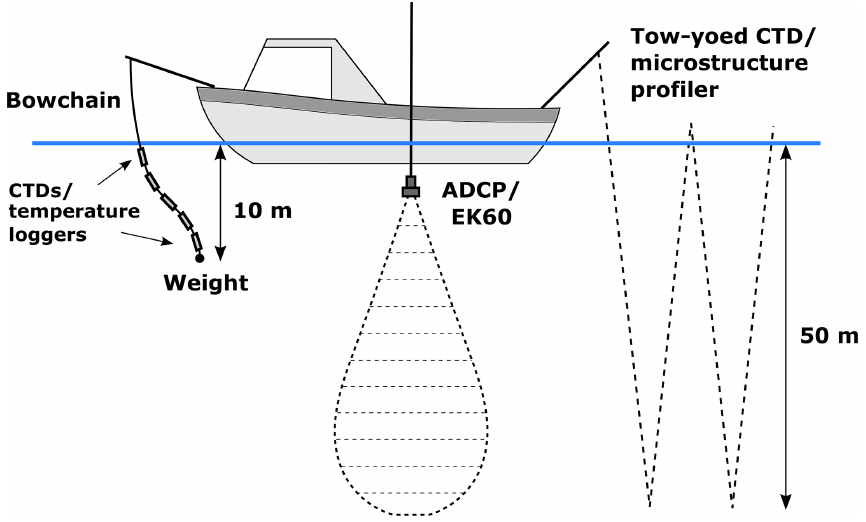
Figure 3. Schematic of vessel-mounted instrumentation setup including bow chain, pole-mounted ADCP and EK60, tow-yoed CTD and microstructure